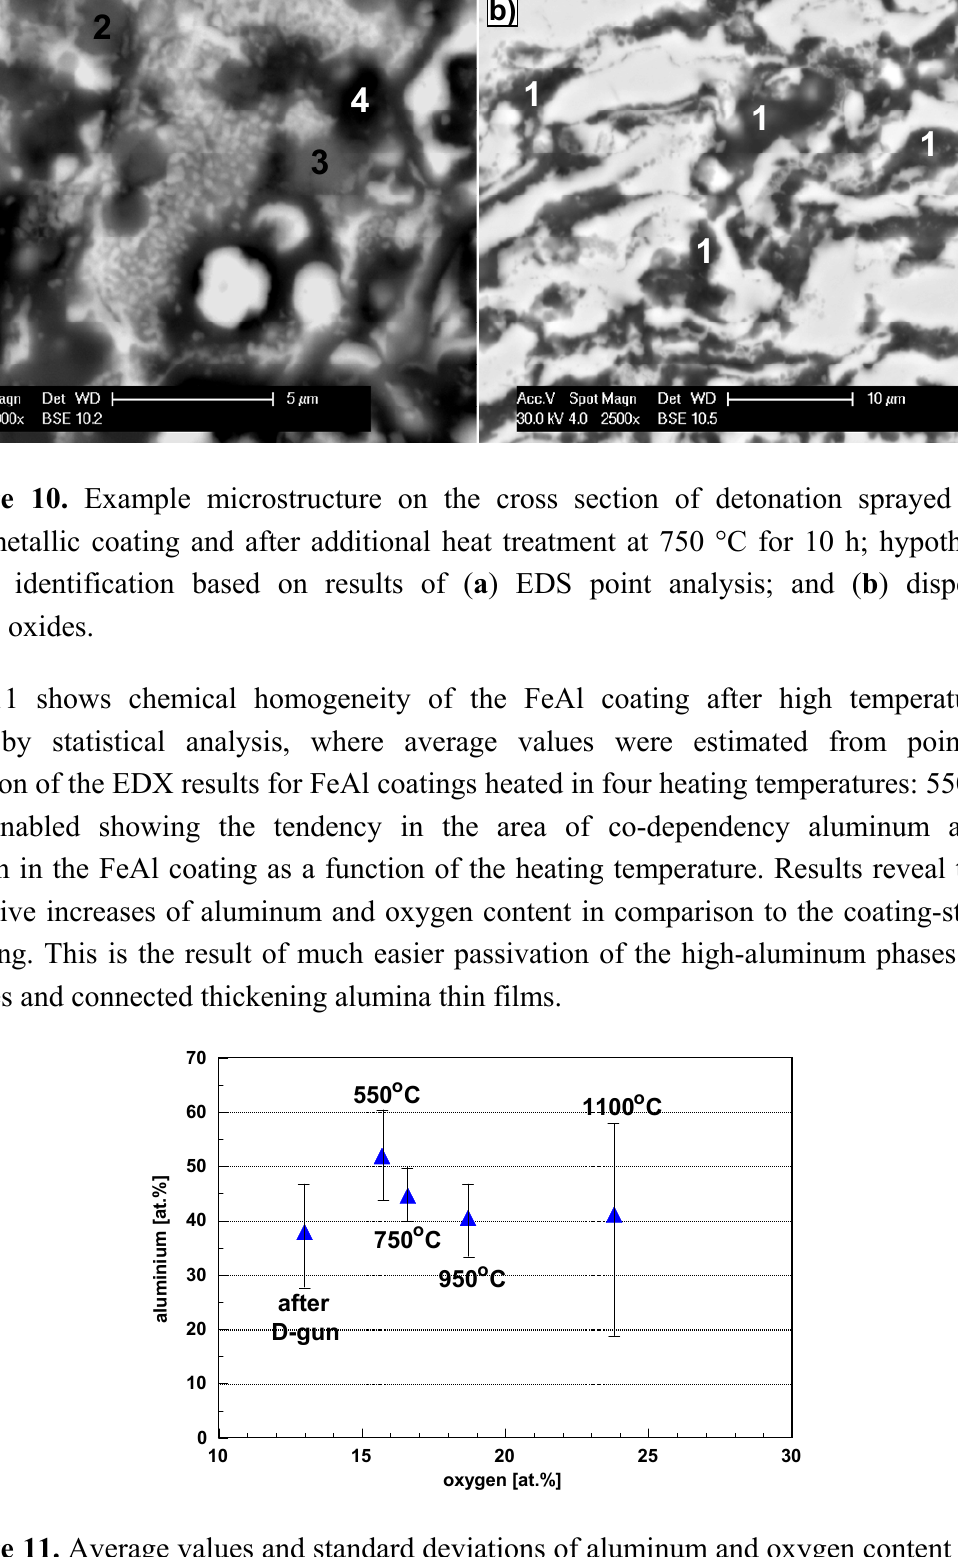
Figure 11. Average values and standard deviations of aluminum and oxygen content based on results of EDS point analysis of FeAl intermetallic coating after D-gun spraying and additional heating treatment, respectively, at 550, 750, 950 and 1100 °C for 10